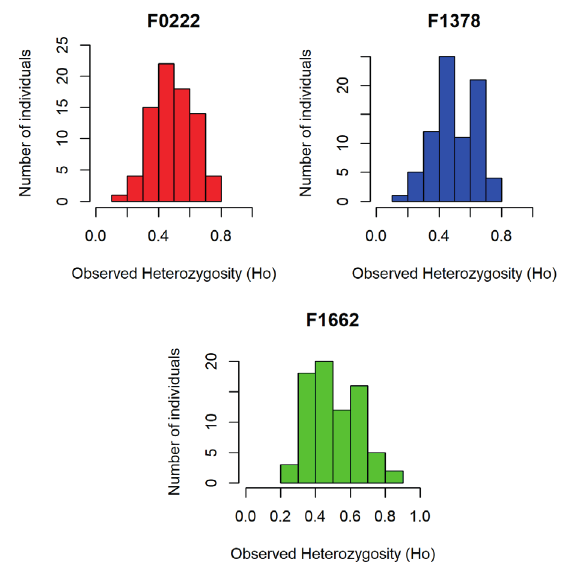
Figure 3 - Distribution of the observed heterozygosity (Ho) 1 of the S cassava individuals from the self-pollination of 1 the accessions BGM0222 (F0222), BGM1378 (F1378) and BGM1662 (F1662).